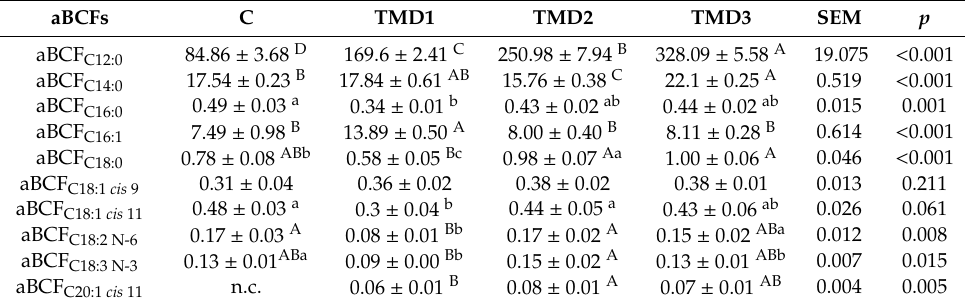
Table 8. Apparent bioconcentration factors (aBCFs) for individual fatty acids found in black soldier fly prepupae (BSFPs) reared on the control (C) or experimental diets (TMD1–TMD3).